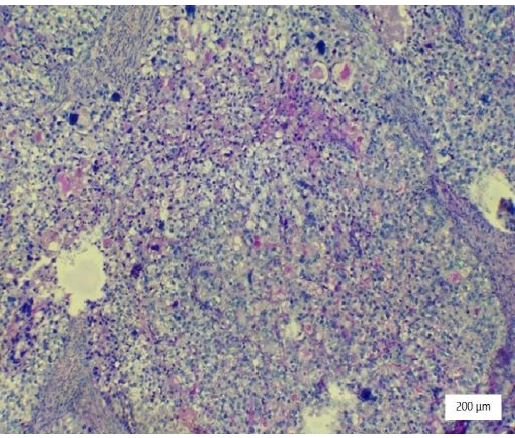
Figure 5. Positive periodic acid – Schiff staining in the cytoplasm (PAS ×100).